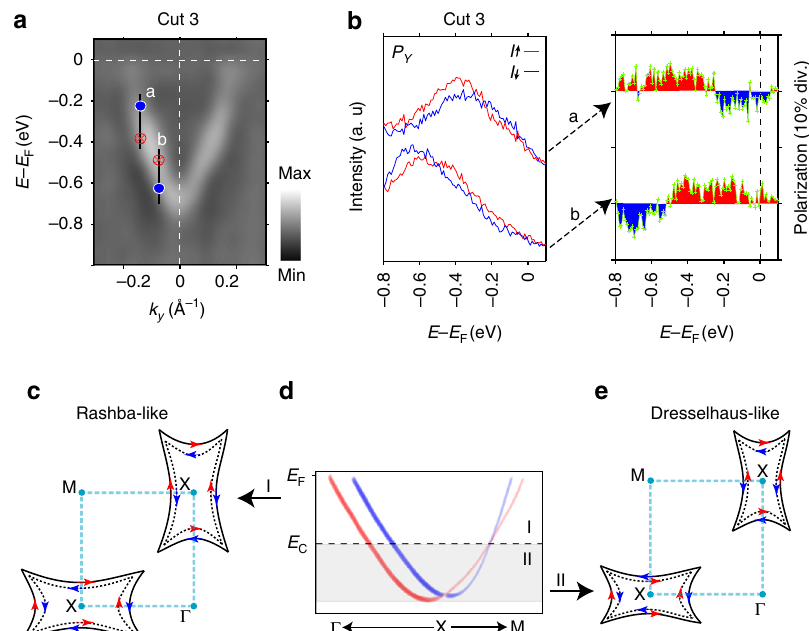
Fig. 3 Summary of the observed transition from Rashba-like to Dresselhaus-like spin textures for LCB. a Band dispersion measured by ARPES ( h ν = 18 eV) along the cut 3 in Fig. 2a (X – M line). b Spin-resolved EDCs of P Y at a and b points in Fig. 2a, right panel shows the corresponding spin polarizations. The peak positions of spin-resolved EDCs are indicated with crosses and dots in a . The reversal of spin polarizations at a and b points leading to a different spin textures (Rashba-like and Dresselhaus-like) in LCB. c The Rashba-like spin texture of the rectangle-like shape FSs at upper part of LCB (region I in d ). e The Dresselhaus-like spin texture of CECs at lower part of LCB (region II in d ) derives from the crossing of spin-polarized LCB at E = E c along X – M line, which was taken from refs. 1,8 and schematically indicated in d . The red and blue colors for arrows and energy bands represent spin-up and spin-down states,